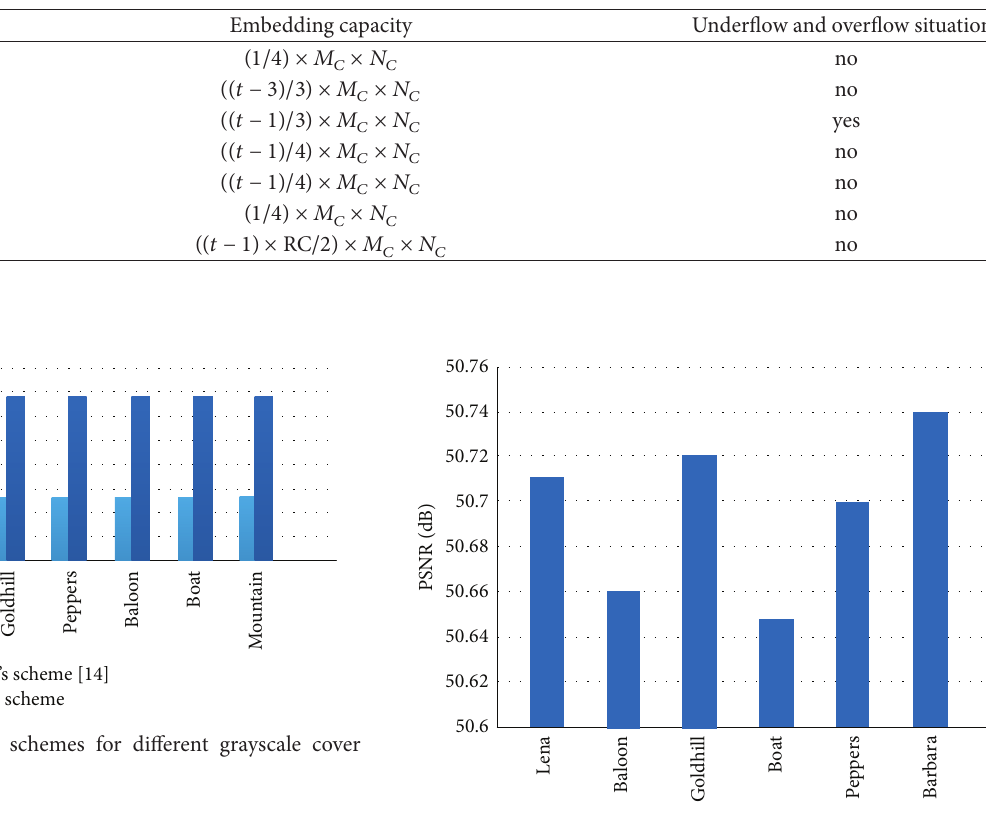
Figure 13: PSNR of the proposed scheme for different binary